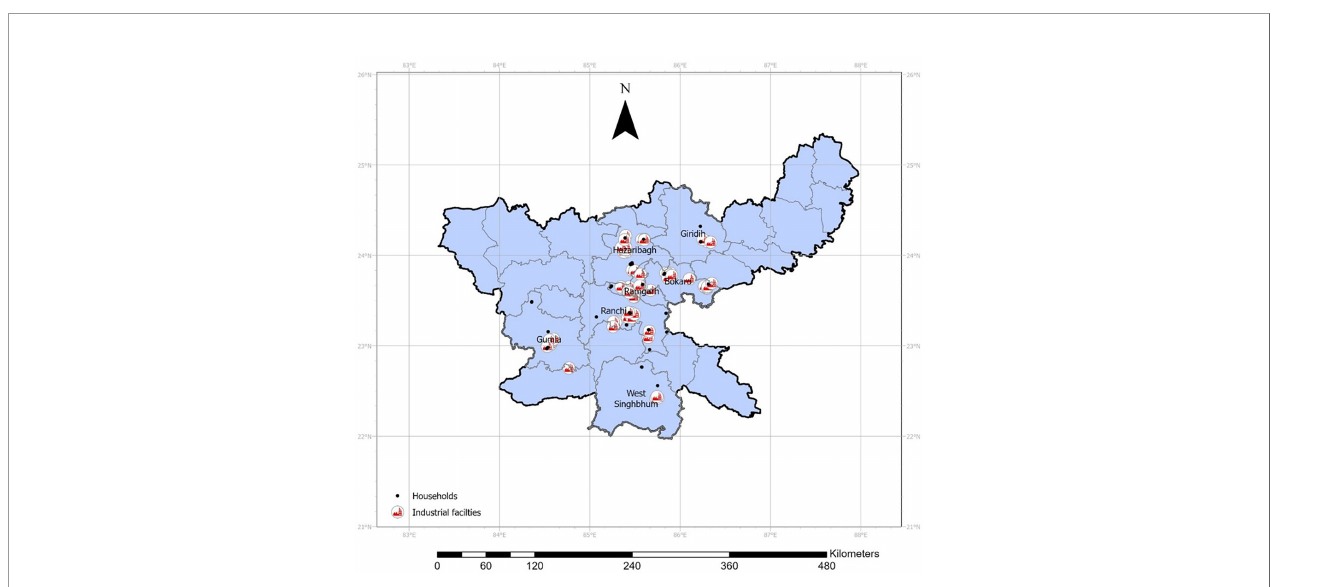
FIGURE 4 | Point locations of households in our study area and surrounding industrial